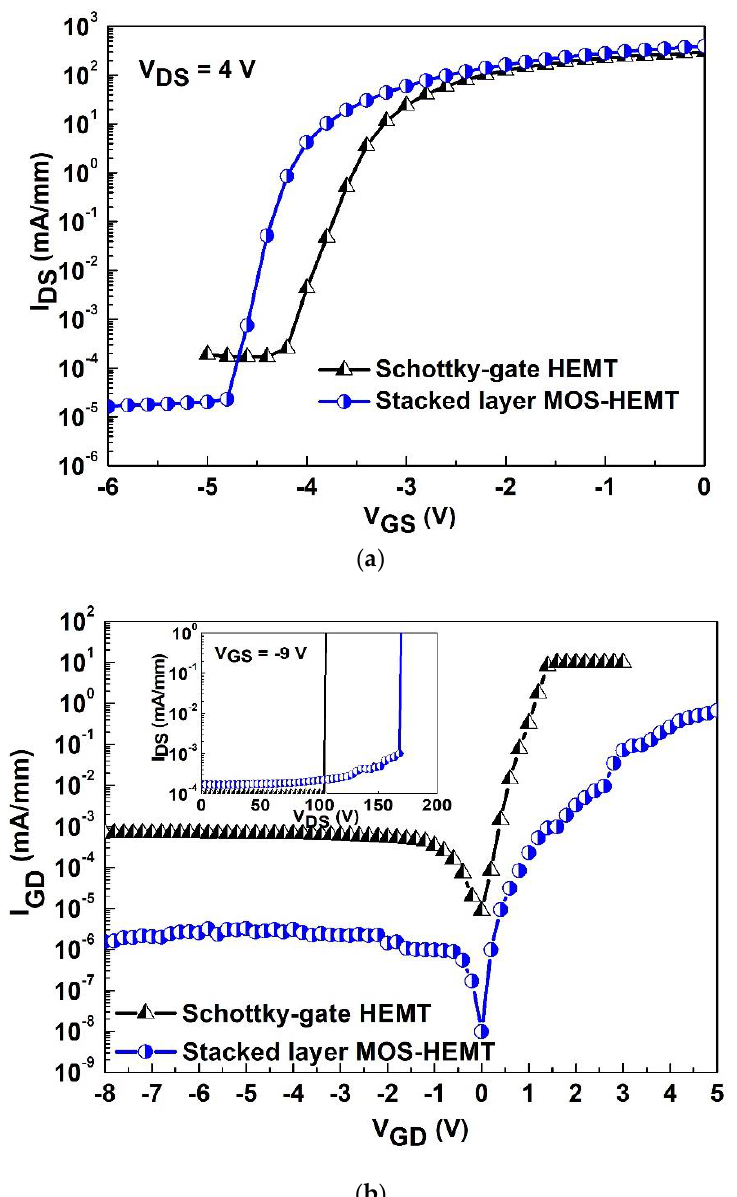
Figure 3. ( a ) Comparison of subthreshold current for the Schottky-gate HEMT and stacked layer MOS-HEMT. ( b ) Comparison of two-terminal gate leakage current for both devices. The inset shows three-terminal off-state breakdown voltage.